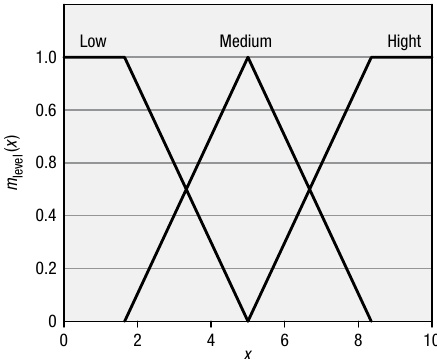
( x ), m ( x ) and m ( x ) of the factor low medium high